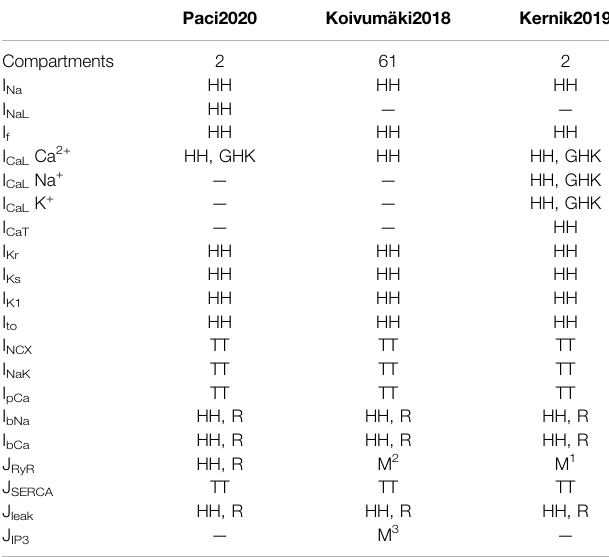
TABLE 1 | Summary of the compartments and the ion currents and fl uxes included in the three